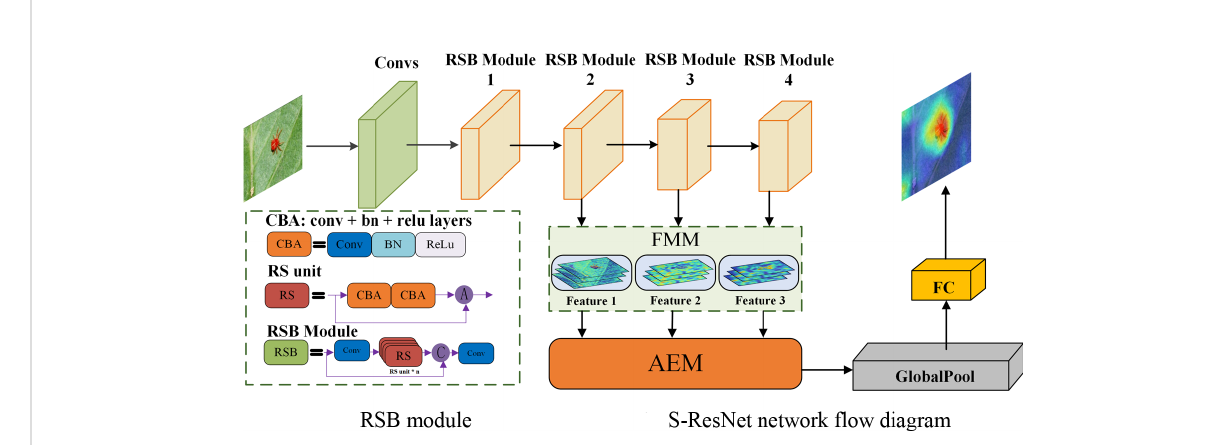
FIGURE 5 S-ResNet overall structure diagram. “ A ” donates the element-by-element summation; “ C ” donates the fusion of the number of feature channels; “ Conv ” donate a convolutional layer; “ RS ” donates a residual structure(The improved residual structure is shown in Figure 7B); “ RSB ” donates a RSB module; “ BN ” donates a normalization operation and “ ReLu ” is the activation